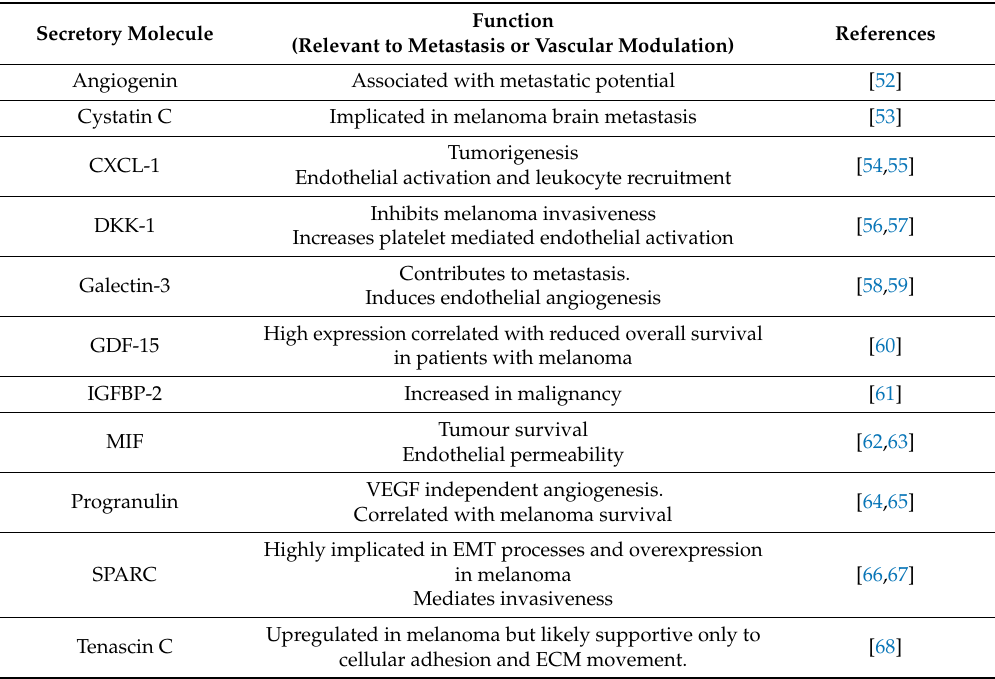
Table 2. Details of secreted factors detected at relatively high levels across multiple melanoma conditioned media using the Proteome